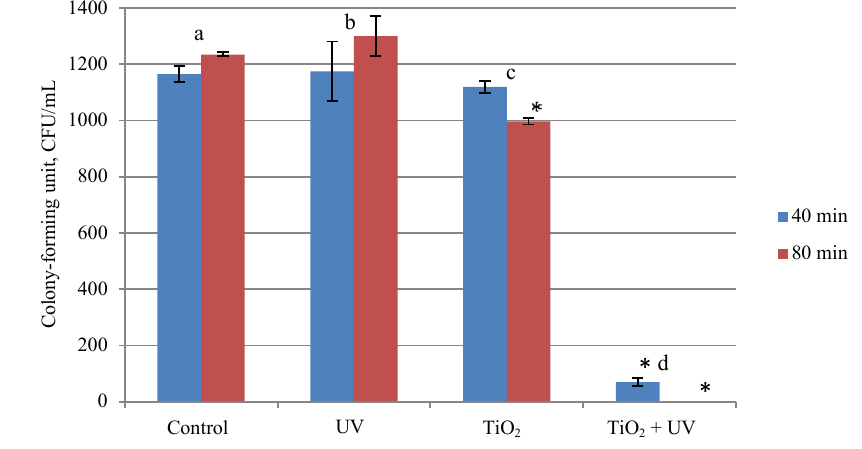
Fig. 3 Viability of S. enterica cells evaluated by SP method ( n = 3): a) Negative control with none-irradiated cells; b) effect of TiO 2 ; c) effect of UV; d) effect of TiO 2 + UV. The experiments were performed at 22 °C, the initial amount of bacteria was 2.7×10 6 cfu/mL, dilution factor 1000. 1 mg/mL of TiO 2 was used and the intensity of UV irradiation was 2 mW/cm 2 . *statistically significant difference compared to control group, using one way ANOVA, p <